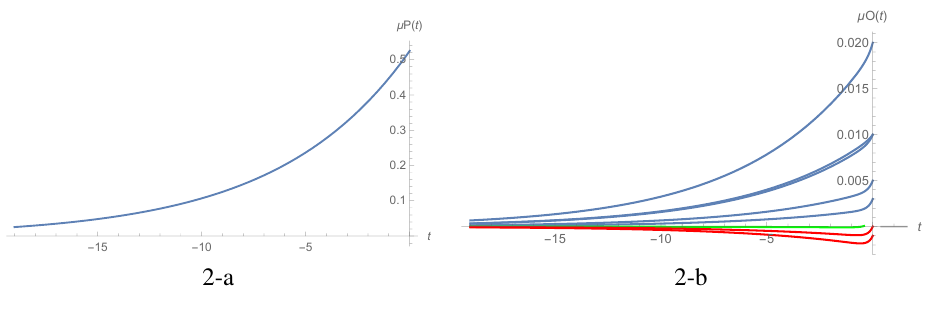
Figure 2. 2-a: We show the trayectories of the dimensionful parameters µ P ( t ) in term of t -evolution, 2-b the trayectories of the dimensionful parameters µ O ( t ) in term of t -evolution